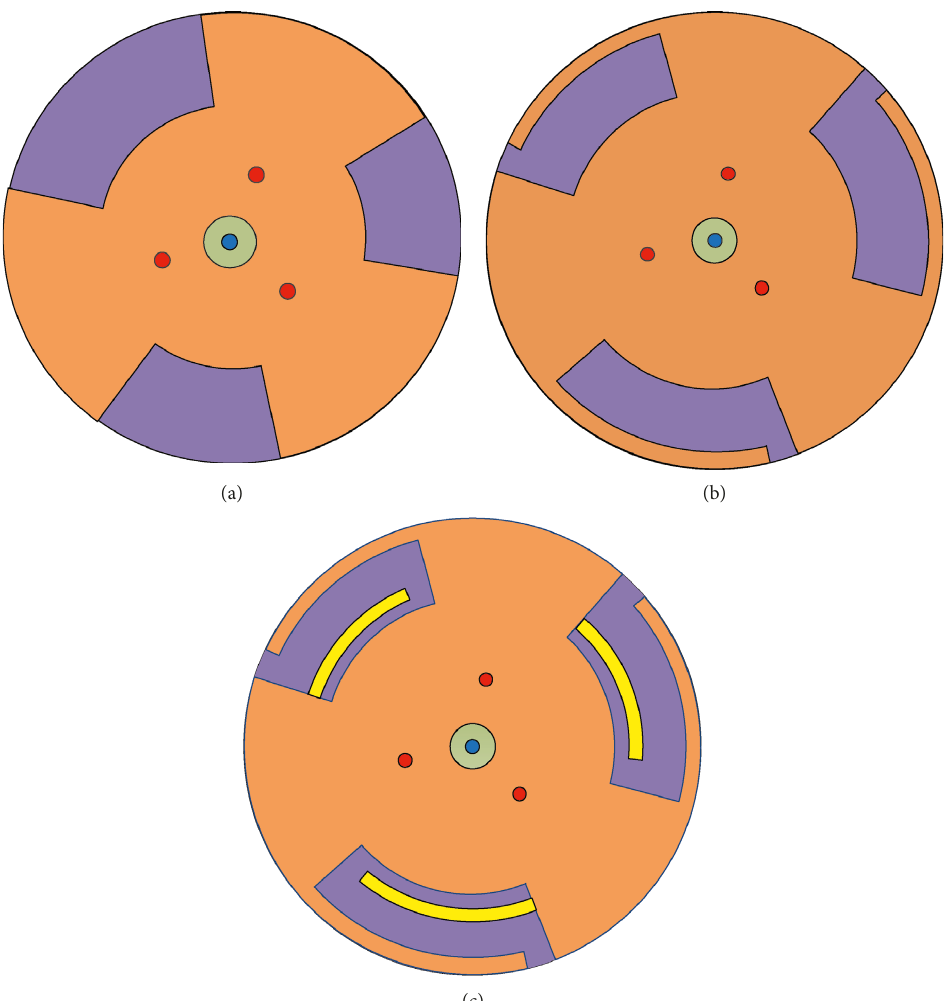
Figure 3: Evolution of the proposed